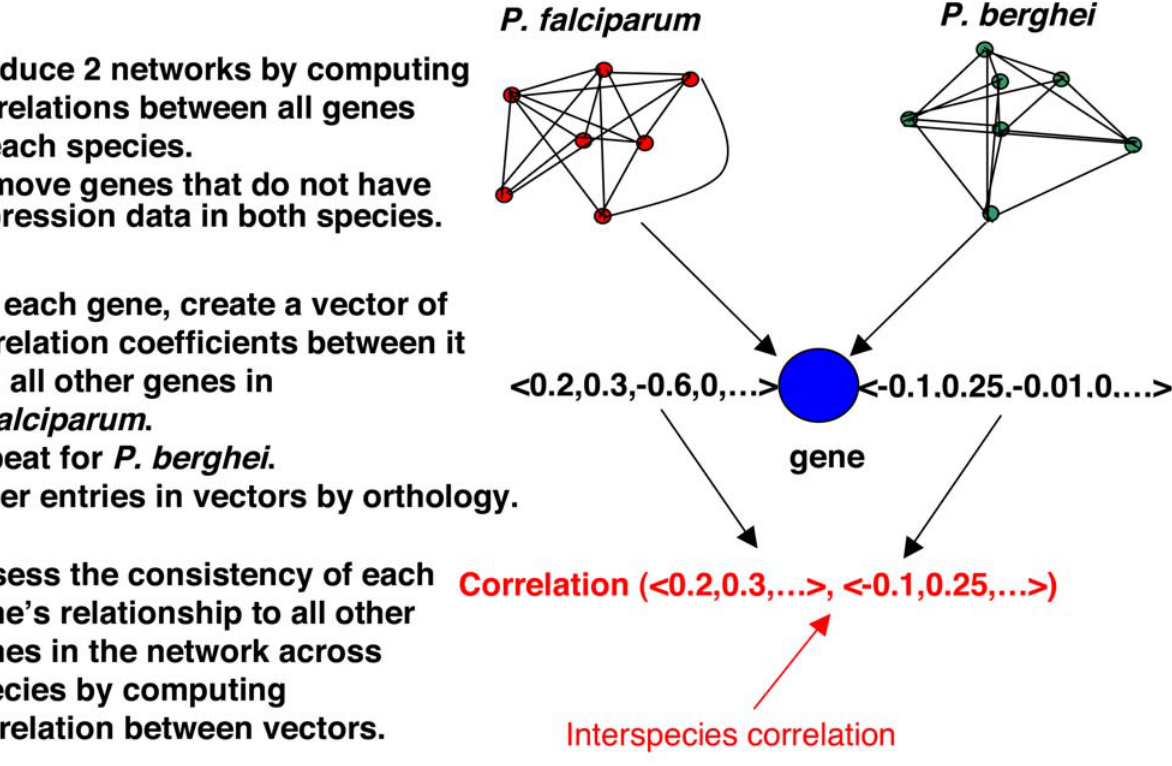
Figure 4. Estimating expression similarity across species. ‘Network-level’ interspecies correlation coefficients are estimated for genes with orthologs in both the P. falciparum and P. berghei expression datasets (see materials and methods for details).